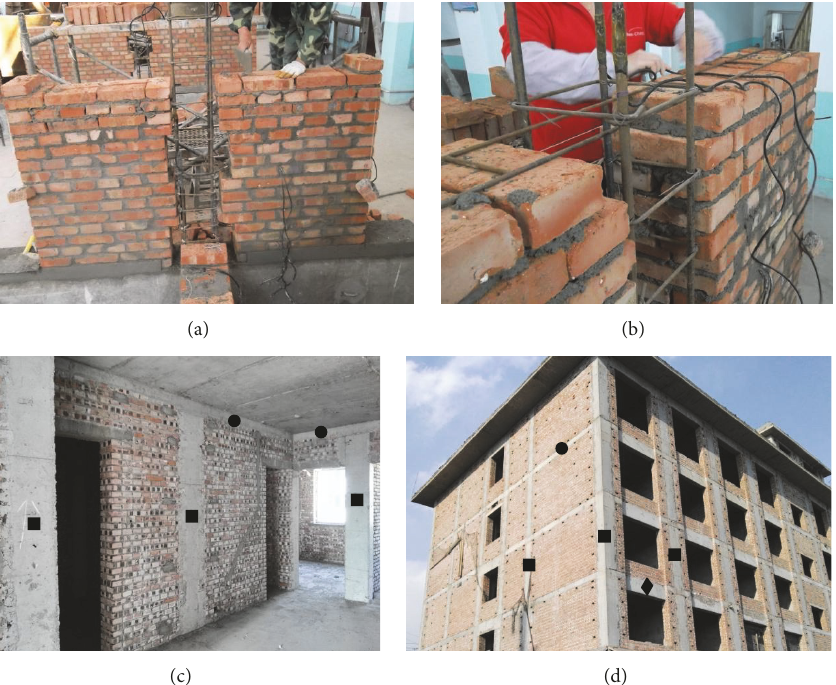
Figure 1: Photographs of construction of SCC and actual masonry walls containing SCC and ring beam ( ◼ : SCC; e : ring beam; ⧫ : merger of ring and lintel